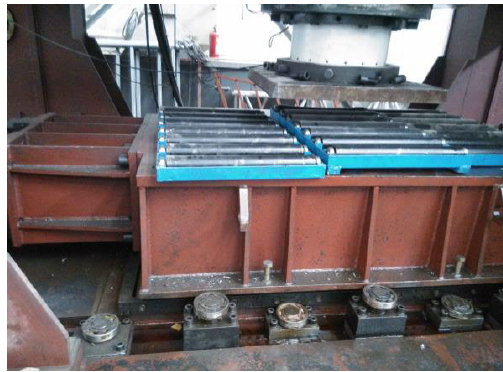
Figure 27. Vertical loading device of specimen 2.